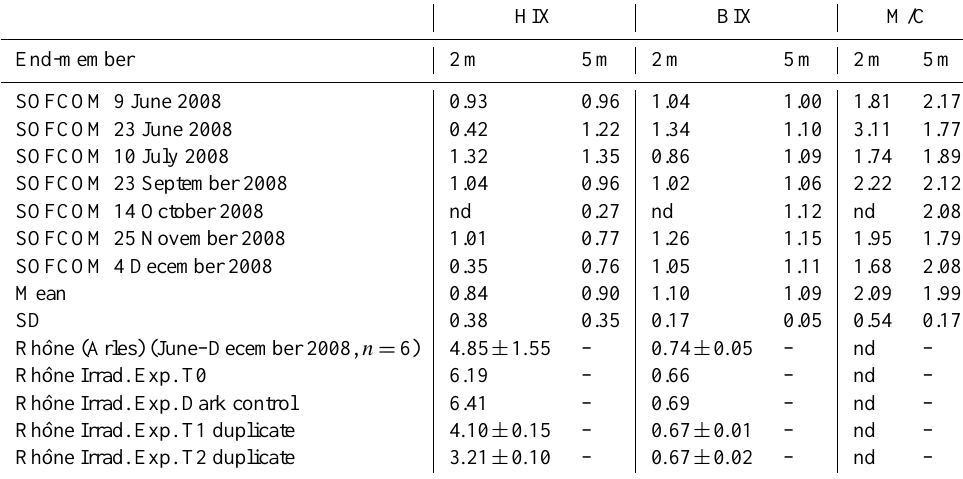
Table 3. Values of Humification (HIX; Zsolnay et al., 1999), Biological (BIX; Huguet et al., 2009) indices and the ratio of marine humic-like (Ex/Em = 300/380–400nm) to humic like (Ex/Em = 350/430–450nm) (M/C) fluorescence determined at SOFCOM (2 and 5m depths) and Arles station (Rhˆone and Rhˆone irradiation experiment: Rhˆone Irrad. Exp.) at 2m depth. (nd = not